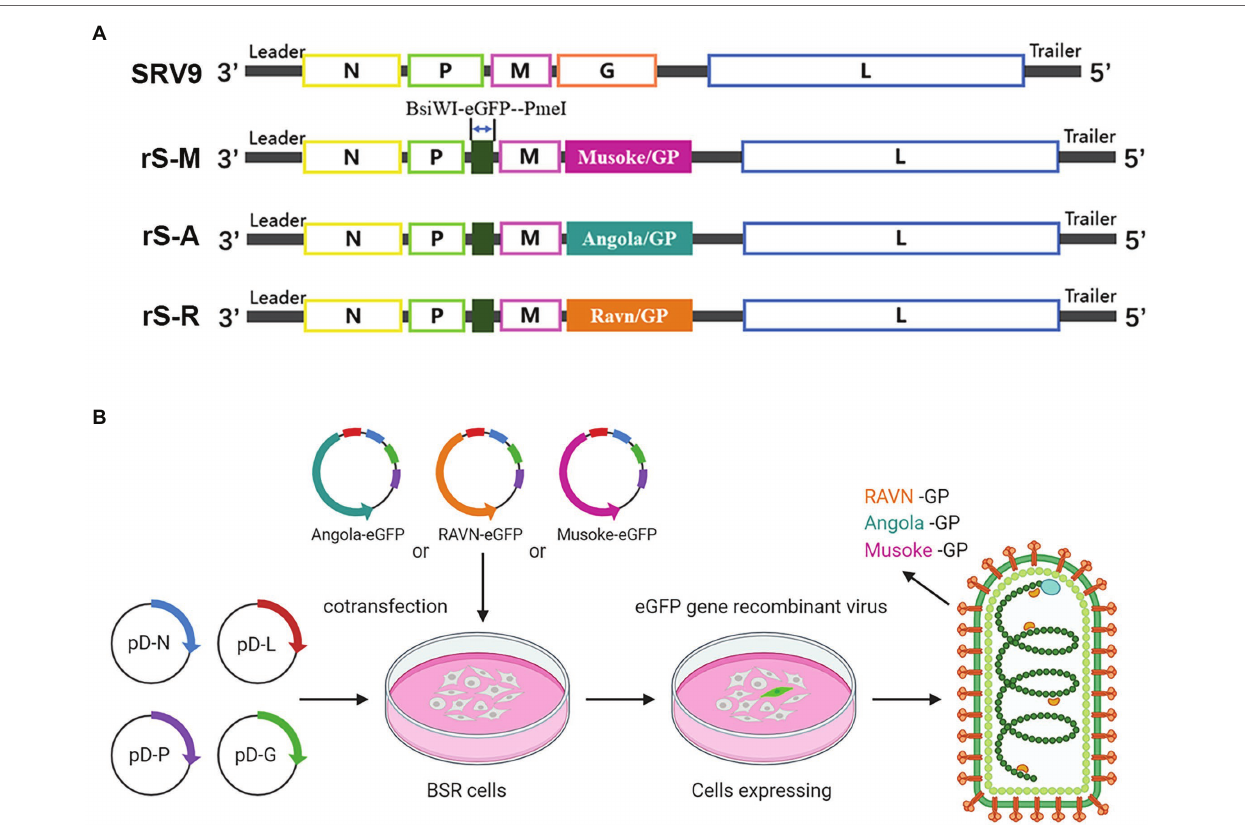
FIGURE 4 | Construction process of recombinant virus (A) The eGFP reporter gene was inserted between the complete genomic sequences encoding RABV phosphorylated protein (P) and matrix protein (M) through two sites, “BsiW I-Pme I.” The original glycoprotein gene sequence of RABV was replaced with the GP sequence of the corresponding strain of MARV to complete the genome modification of the recombinant virus. (B) The full-length vector carrying the modified complete genome was transfected into BSR cells together with the helper vector expressing the four structural proteins of RABV to complete the packaging of the recombinant virus. Three recombinant viruses with rhabdovirus morphology and green fluorescence properties were obtained, and the surface glycoprotein was MARV